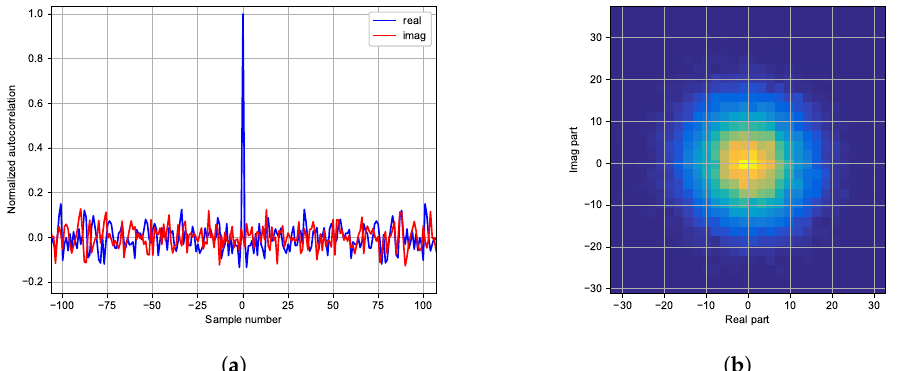
Figure 8. ( a ) Normalized autocorrelation of the system noise using the unbiased method. ( b ) 2D histogram of the system noise shown in Parula colormap. The empirical cross correlation between real and imaginary parts is estimated as ≤ 0.05 in absolute value.